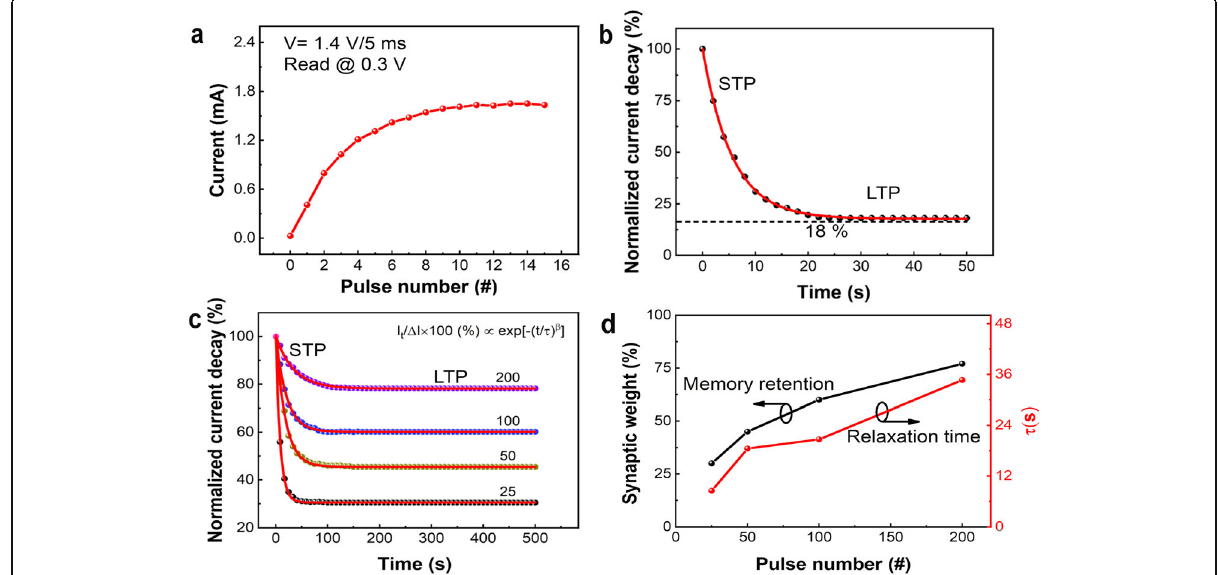
Fig. 6 Current decay and memory retention in Ag/SiO x :Ag/TiO x /p ++ -Si memristor. a Increase in current after implementation of consecutive 15 potentiating identical pulses. b Current decay is monitored at a reading voltage of +0.3 V after stimulating the device. c The normalized current decay versus time showing the transition from STP to LTP after implementation pulse trains of the number of stimulation. d The memory retention and relaxation time ( τ ) to pulse numbers